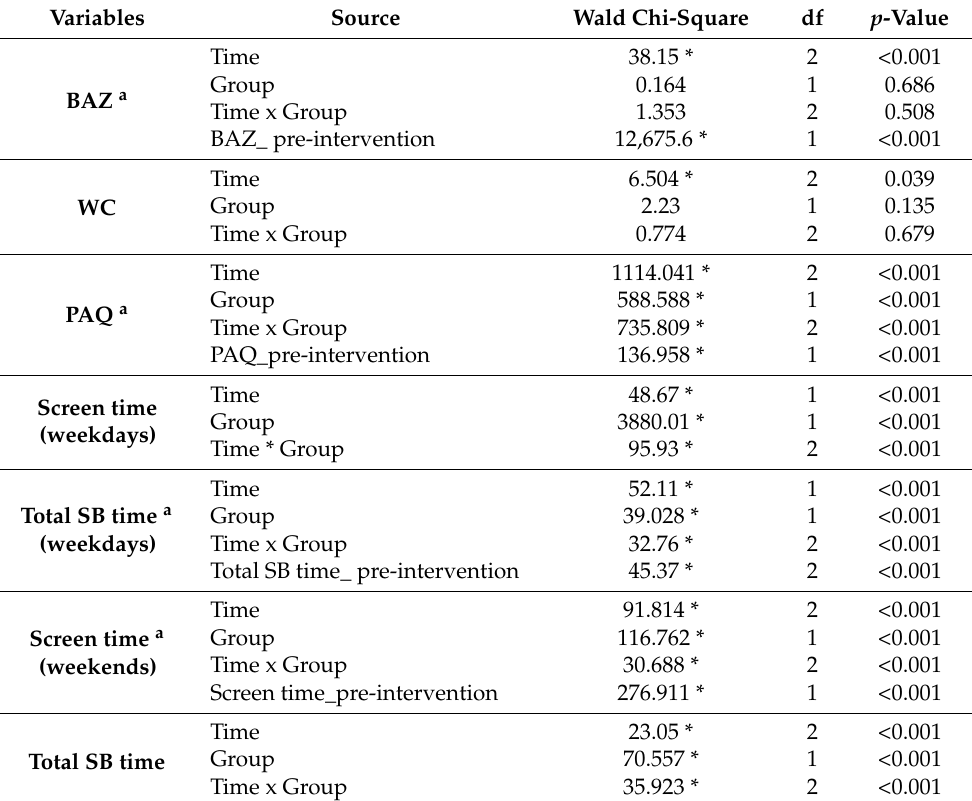
Table 2. Results of BMI-for-age z-score, waist circumference, physical activity, and screen time and the total sedentary behavior on weekdays and weekends based on generalized estimating